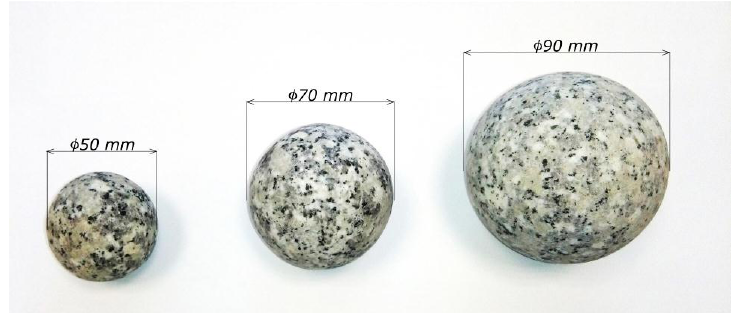
Figure 5. Granite spheres used in the experiment.